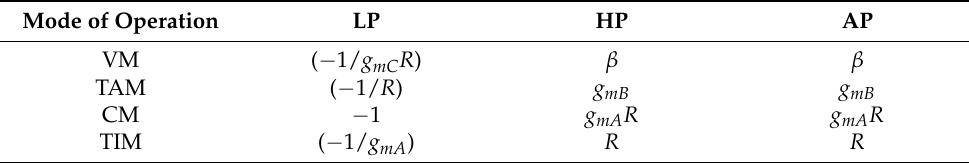
Table 2. Passband gains of the proposed mixed-mode first-order filter in Figure 2. Mode of